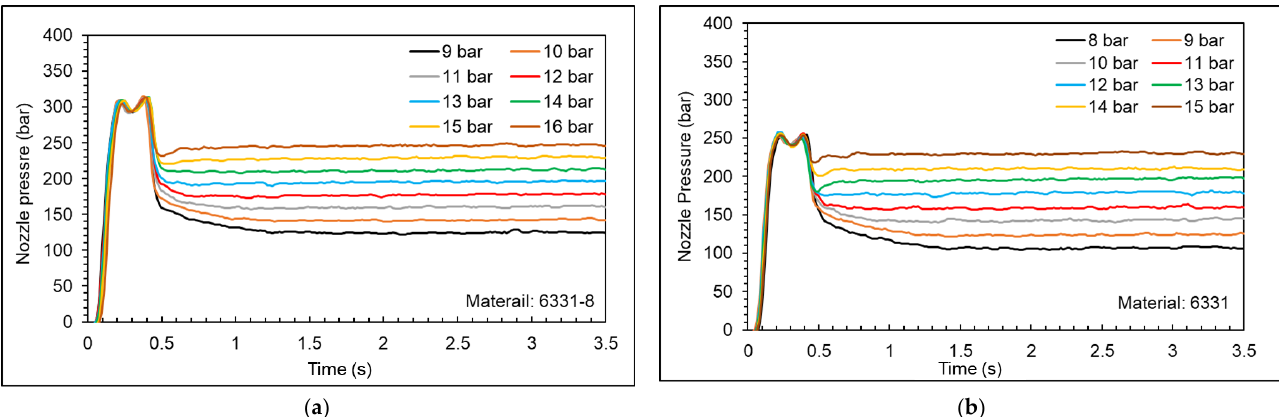
Figure 15. Cavity pressure profiles at different packing pressures (( a ) 6331 − 8, ( b ) 6331, and ( c ) PT231).